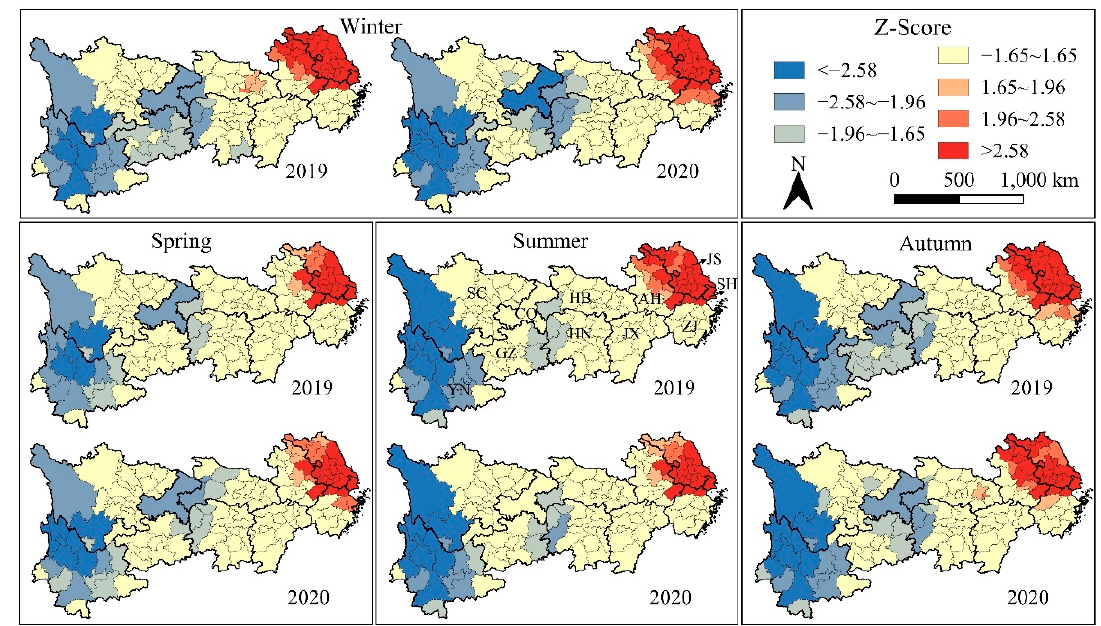
Figure 6. The characteristics and evolution of the NO 2 VCD spatial agglomeration.